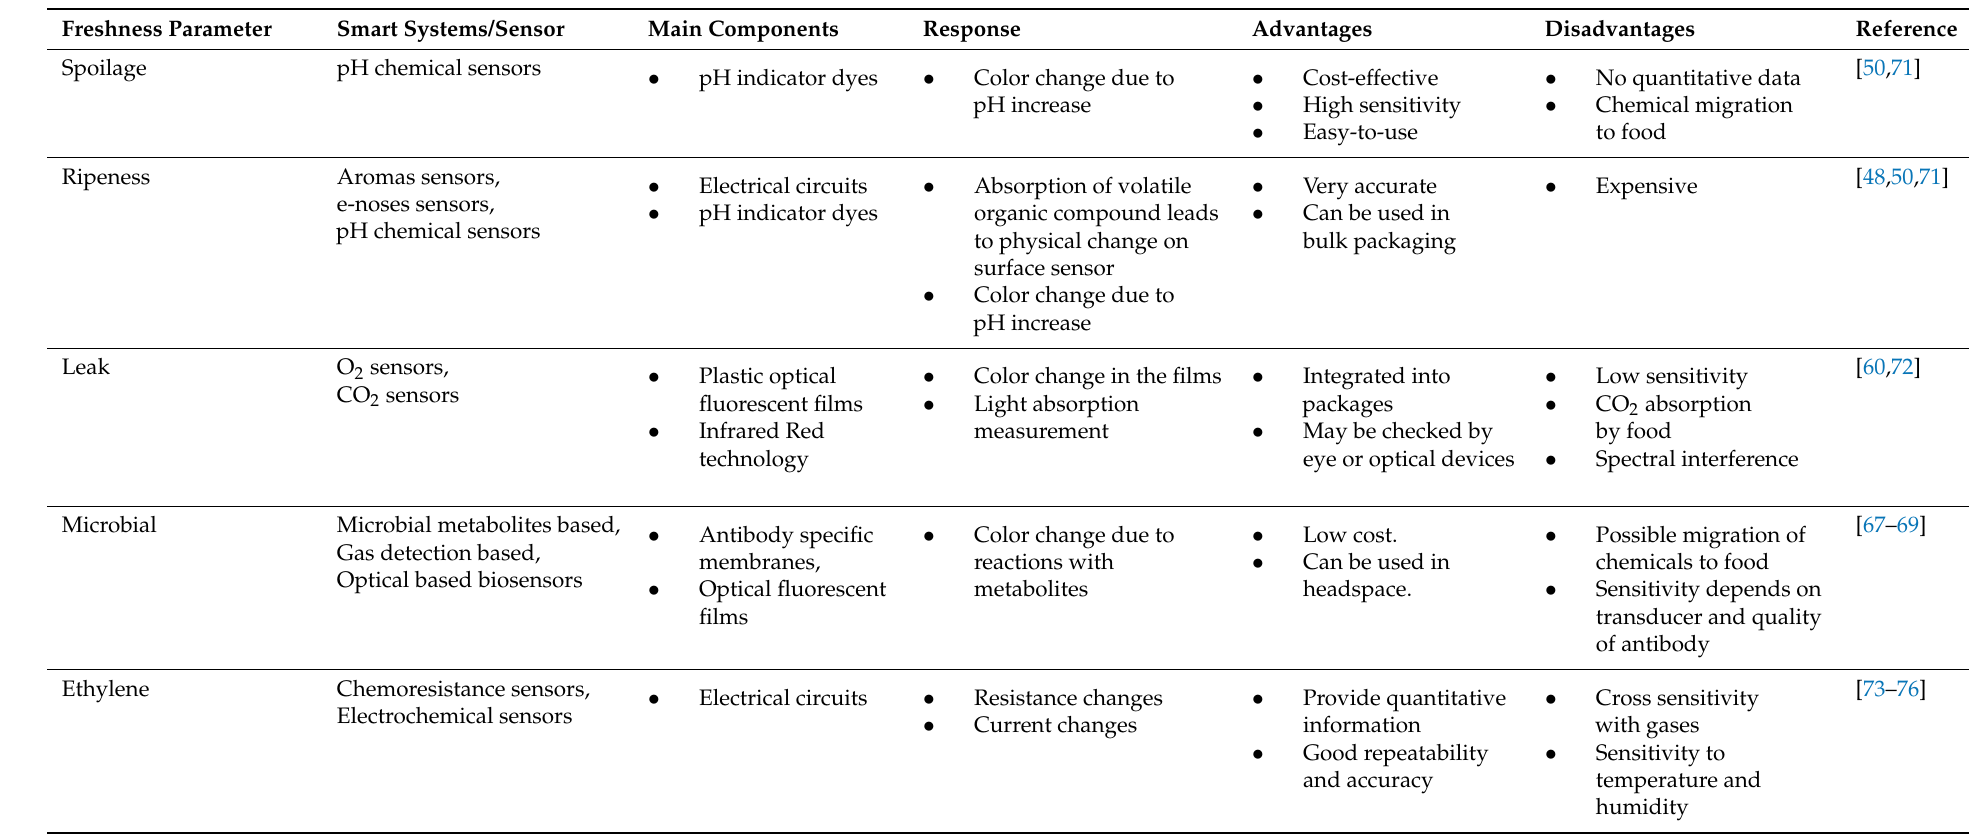
Table 2. Comparison between different direct freshness